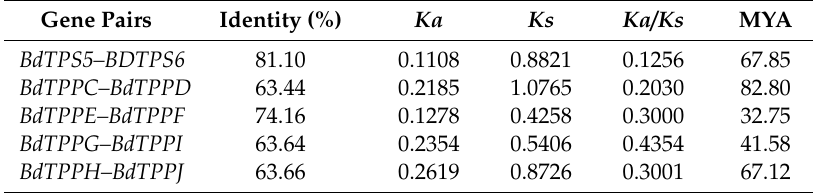
Table 2. The duplicated BdTPS/BdTPP genes and Ka/Ks analysis.